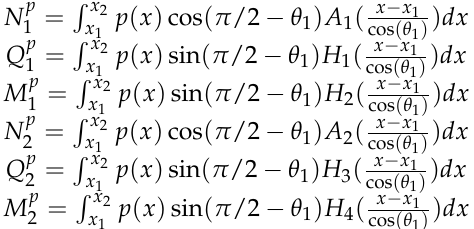
Figure 2. Free body diagram. The vertical force p ( x ) is equivalent to horizontal and vertical component forces to calculate the equivalent internal structural forces. The derivation is shown as: